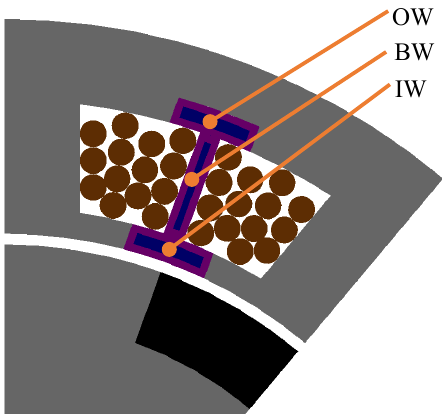
Figure 7. Illustration of three heat exchanger positions in radial flux motor inter-winding positions demonstrated in the literature: outside of windings (OW), between windings (BW), and interior of windings